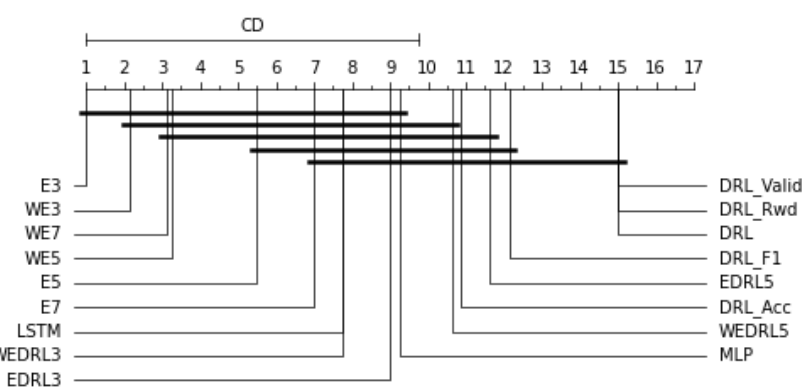
Figure 10. A critical difference diagram.